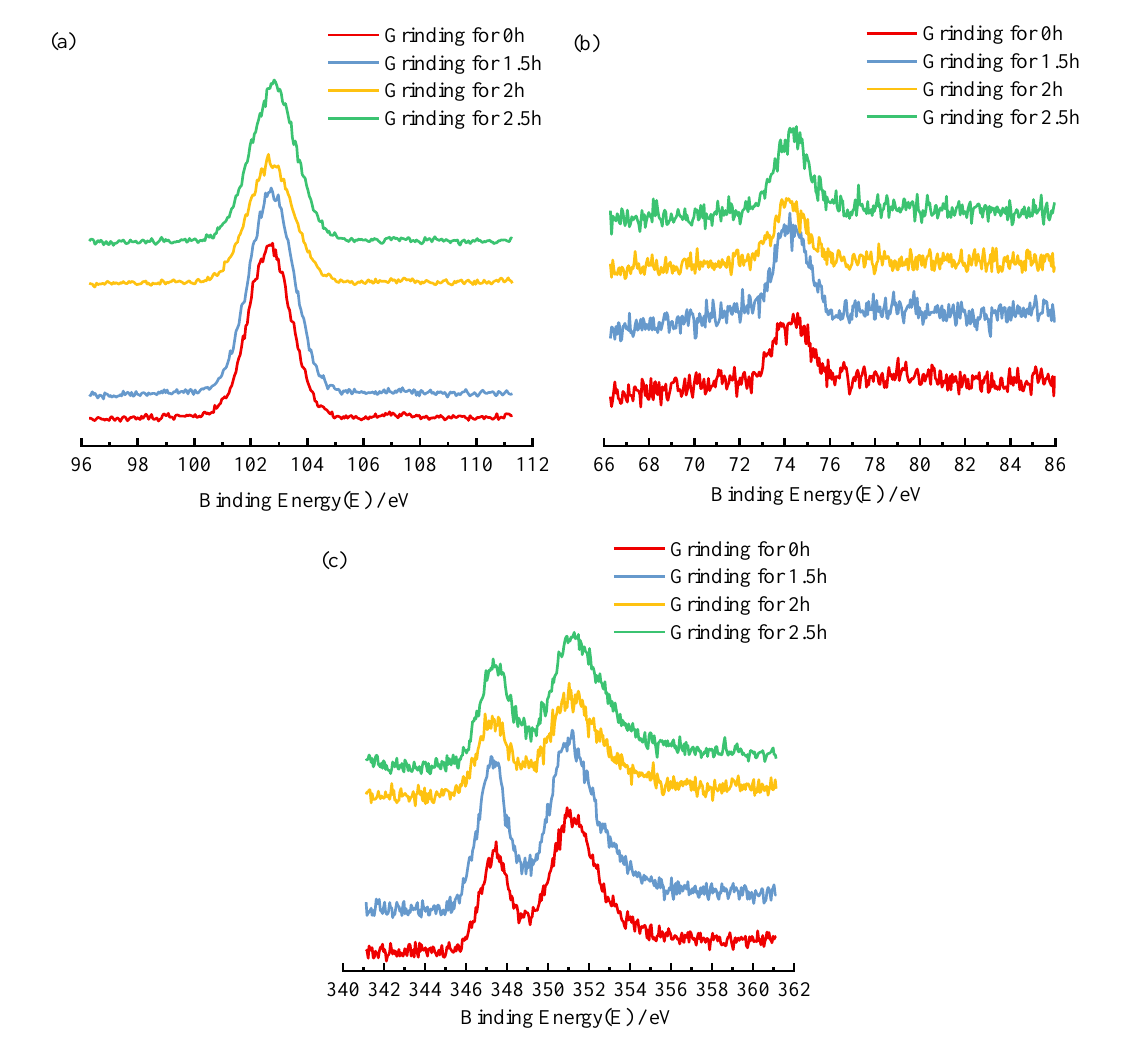
Figure 7. XPS patterns of IOTs at different grinding times of ( a ) binding energy of Si2p, ( b ) binding energy of Al2p, and ( c ) binding energy of Ca2p.